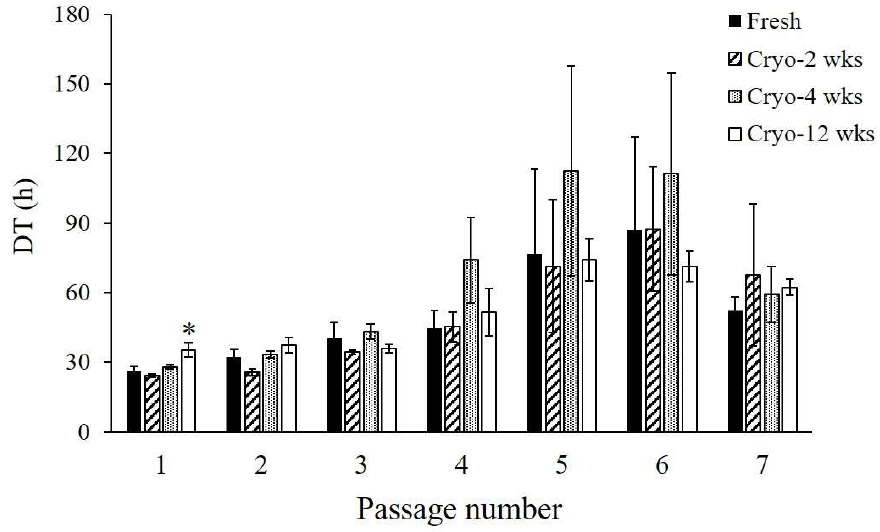
Figure 1. Doubling time of adipose-derived stem/stromal cells (ASCs). ASCs derived from fresh or cryopreserved adipose tissue were cultured for up to seven passages. Doubling time (DT) was determined at the indicated number of passages (as described in the Materials and Methods section). Data are expressed as the mean ± standard error (SE) ( n = 4). * p < 0.05 vs. Fresh.